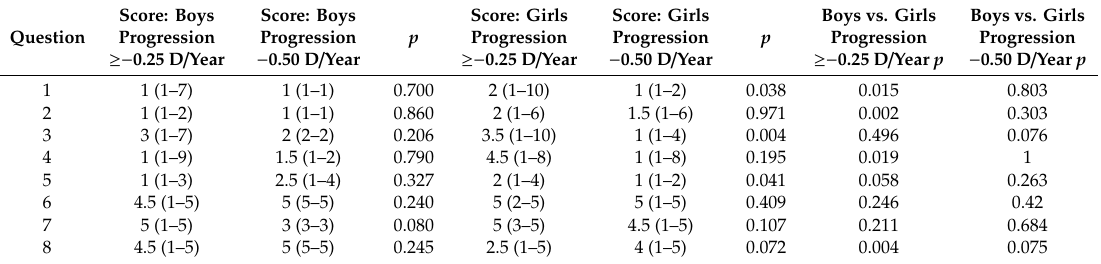
Table 2. Answer scores for: groups of boys with progression ≥− 0.25 D / year ( n = 16) and − 0.50 D ( n = 2) and groups of girls with progression ≥− 0.25 D / year ( n = 14) and − 0.50 D ( n = 8), presented as median value (range) and p (Mann − Whitney U-test with continuity correction). In the last two columns, p for inter-gender di ff erences in scores for both myopia progression rates is